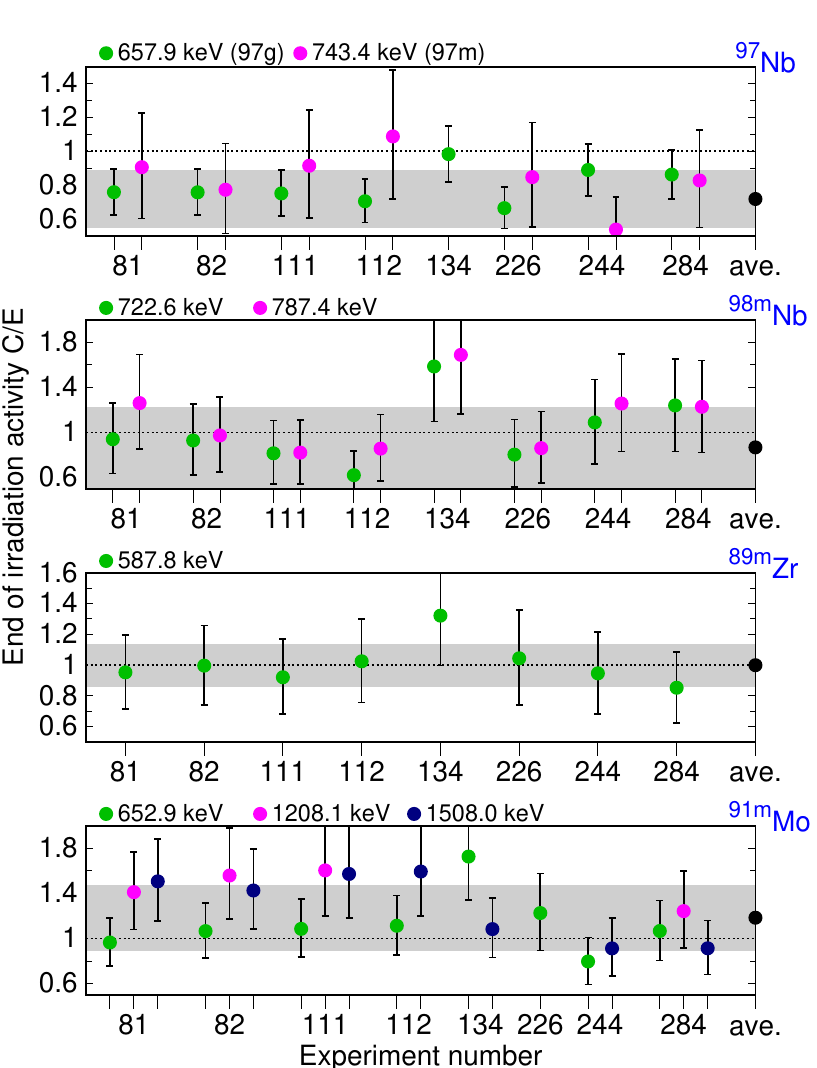
Figure 2: The complete set of C/E values calculated for the ASP experiments involving Mo foils. The colour of a point indicates which γ -peak it is associated with (listed at the top of each pane). Points are grouped by experiment along the x-axis. Each pane corresponds to the peaks of a different radionuclide, except for the top pane, where the single measured peaks from each of 97 Nb and 97 m Nb are shown together. The weighted-average C/E value for all peaks in each pane is also plotted in black, and the grey band behind the data represents the standard deviation of the C/E values from this average. See the main text for